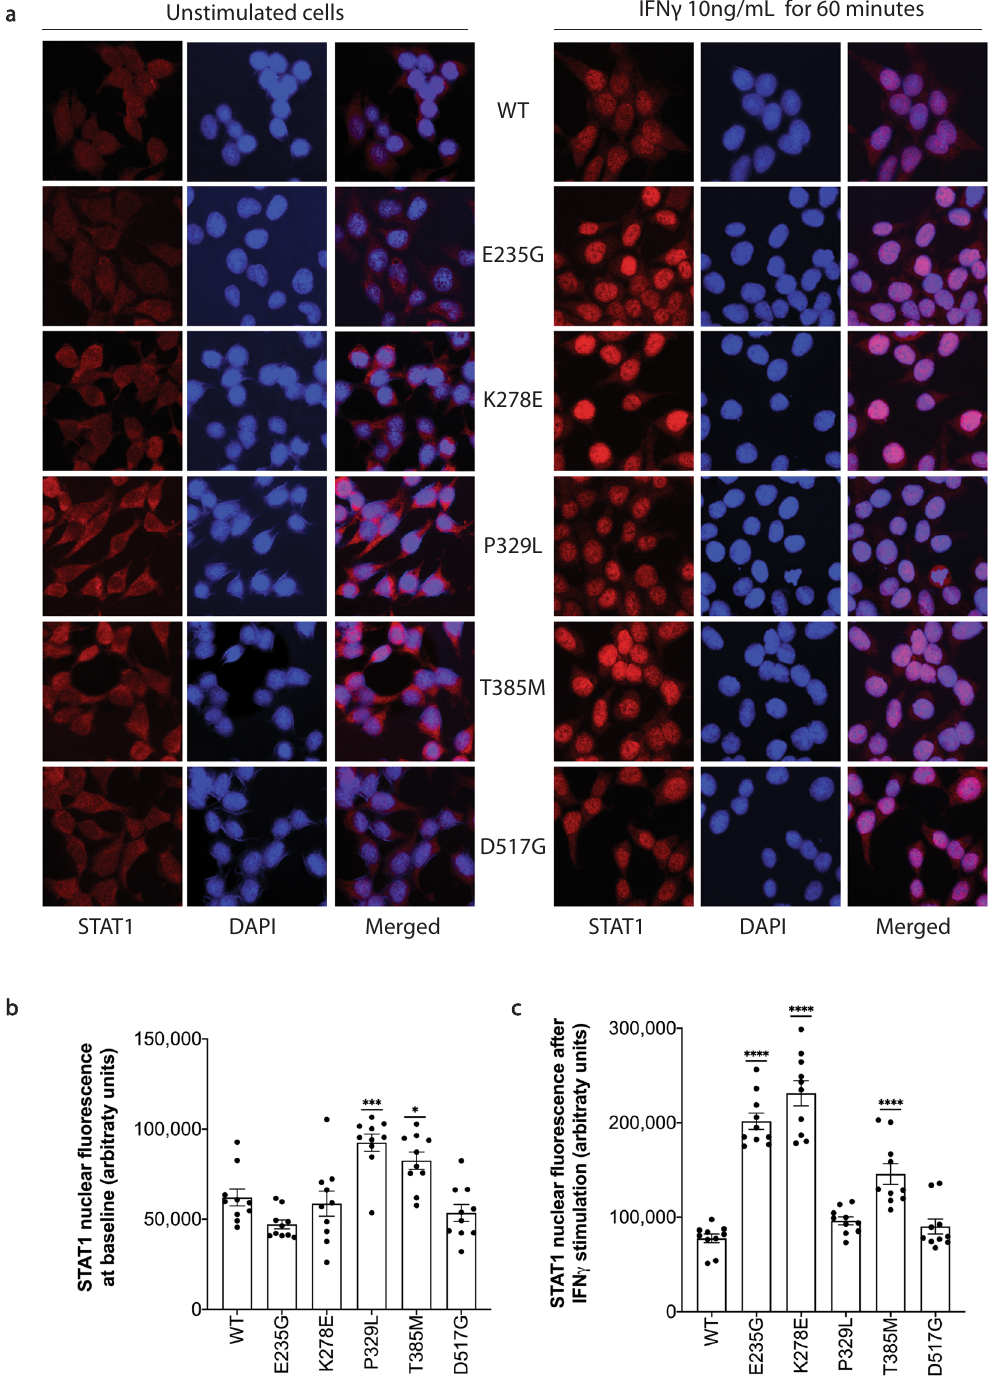
Fig. 6 Immuno fl uorescence analysis of STAT1 nuclear accumulation among wild type and gain-of-function mutants. a Immuno fl uor- escence assessing STAT1 nuclear localization was performed in cells at baseline (left) or following a 60-min stimulation with IFN γ (10 ng/mL). STAT1 is designated in red, while DAPI staining for nuclei is designated in blue. b Quanti fi cation of STAT1 from 10 nuclei per unstimulated sample. c Quanti fi cation of STAT1 from 10 nuclei per IFN γ -stimulated sample. Data are represented as mean ± standard error of mean. Statistical analysis: one-way ANOVA with Dunnett ’ s post hoc test ( *p < 0.05, ** p < 0.01, *** p < 0.001, **** p < activity has been implicated in the pathogenesis of human aortic features. While both mutations are characterized by predisposition aneurysms 70,71 . However, the connection between speci fi c phe- to fungal and viral infections and autoimmunity, aneurysms have only been described in T385M patients. This can perhaps be notypic features and transcriptional patters emerging from this related to our fi nding in the T385M mutant of enhanced work remains early and speculative, and requires further work. transcriptional responses to IFN α across all genes measured, Other factors to consider and explore may include differential which is not observed in P329L. Indeed, increased type I IFN activation of STAT1-dependent and -independent transcription